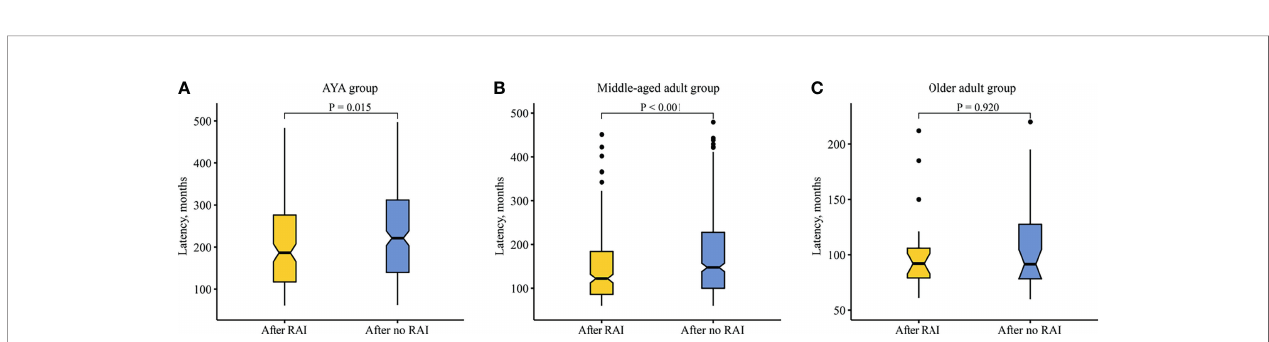
FIGURE 3 | Comparison of latency between SBC patients after radioiodine and after no radioiodine. (A) AYA group. (B) Middle-aged adult group. (C) Older adult group. RAI, radioiodine; AYA, adolescent and young adult.